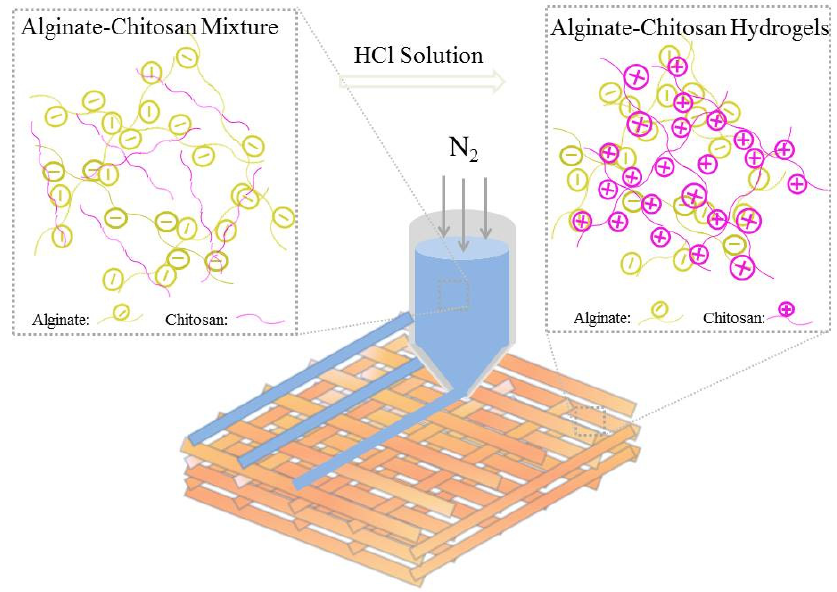
Figure 1. Schematic diagram of three-dimensional (3D) printing alginate–chitosan polyion complex